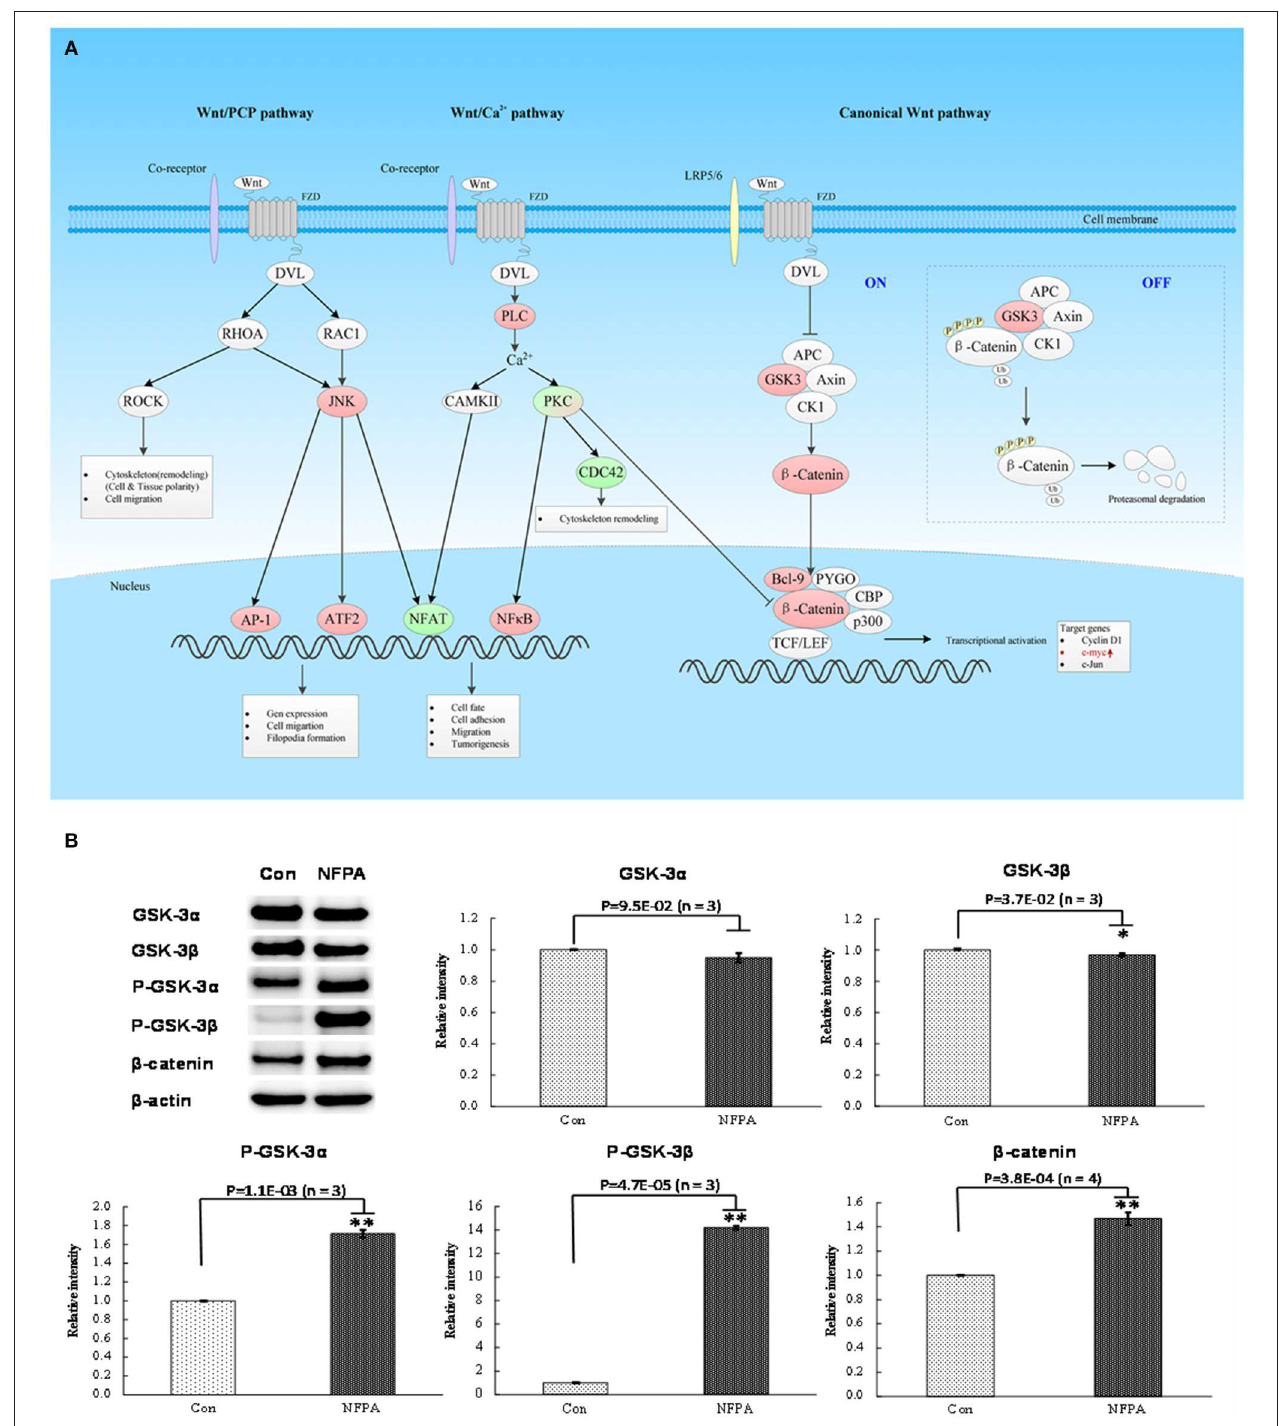
FIGURE 5 | Wnt signaling pathway was involved in NFPA. (A) Wnt signaling pathway was derived from PTMScan results of NFPAs compared to controls. The red color means upregulation of a molecule in NFPAs, and the green color means downregulation of a molecule in NFPAs. The gradient color degree means slightly different expression tendency of that molecule. (B) Activation of canonical Wnt pathway in NFPAs was verified by Western blot results of GSK-3 α , GSK-3 β , p-GSK-3 β (Ser9), p-GSK-3 α / β (Ser21/9), β -catenin and β -actin in control pituitaries (Con) and NFPAs ( n ≥ 3). The relative intensity was the ratio of absorbance units of NFPAs compared to Con. * p < 0.05, ** p <